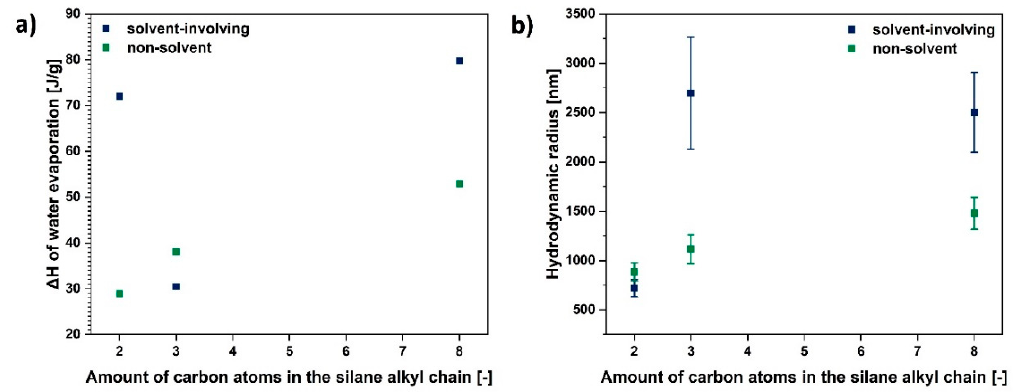
Figure 7. Graphs illustrating: ( a ) ∆ H assigned to water evaporation and ( b ) hydrodynamic radius as a function of amount of carbon atoms in the silane alkyl chain.